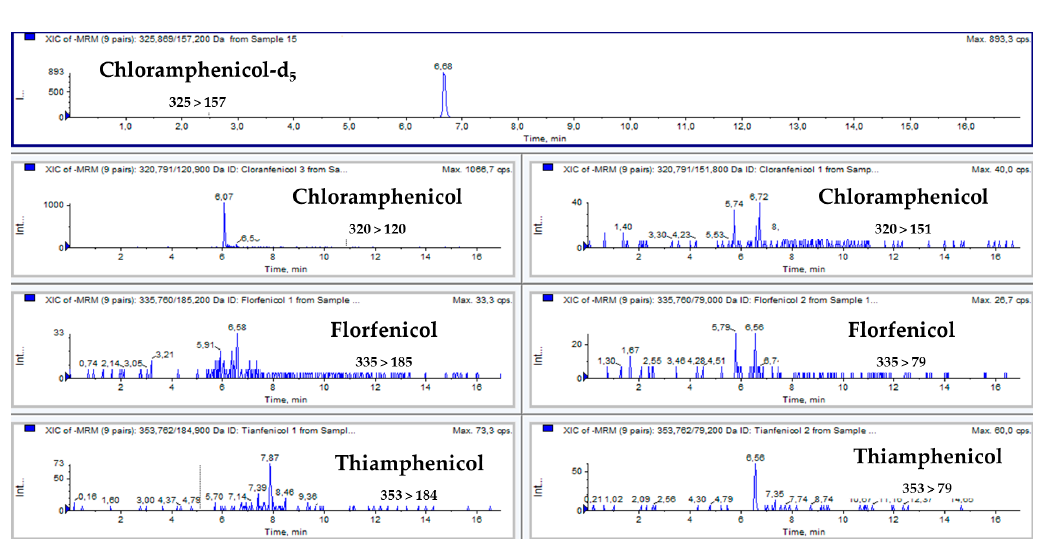
Figure 1. The total ion chromatogram (TIC) of a blank feed sample.